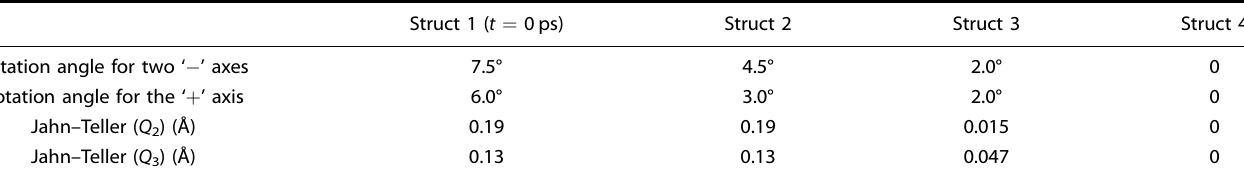
Table 1. The rotation angles and Jahn – Teller distortion ( Q 2 , Q 3 ) for the four atomic structures in fi rst-principles calculations. De fi nition of Jahn-Teller distortion amplitudes Q 2 and Q 3 is shown in Supplementary Fig. 11.